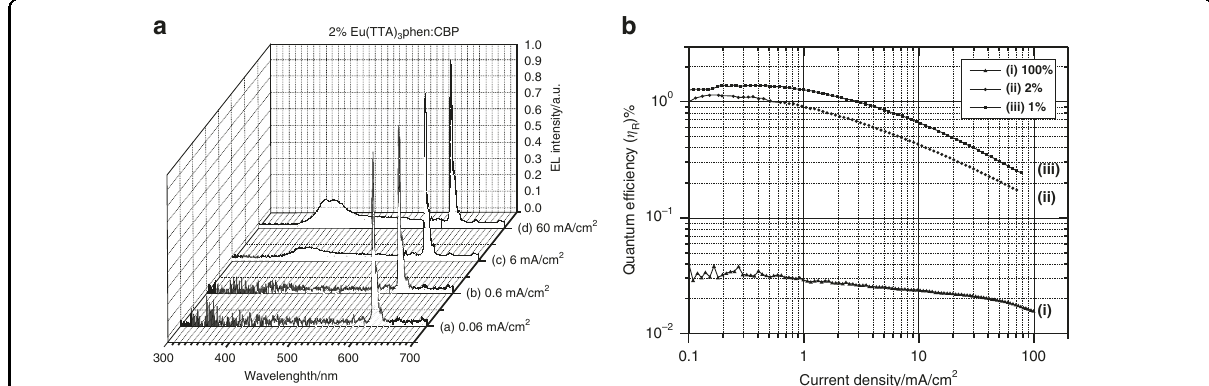
Fig. 8 The EL features of Eu-2 based devices. ( a ) EL spectra. ( b ) EQE-current density (EQE -J ) characteristics. Reprinted from [58], with the permission of AIP doped CBP system, EL ef fi ciency monotonously increases with the increase of holes injection. This phenomenon is attributed to holes accumulation within EML, leading to